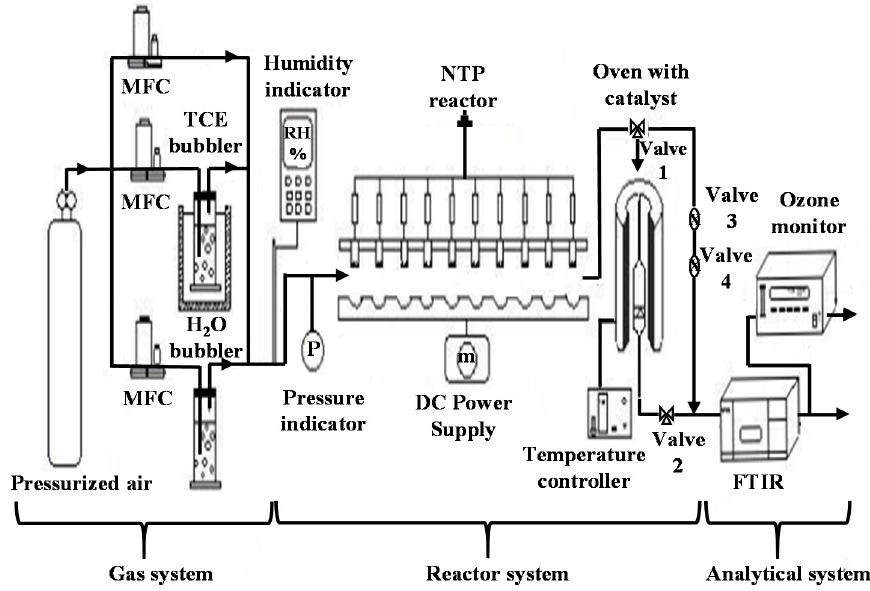
Figure 14. Schematic diagram of the experimental setup.